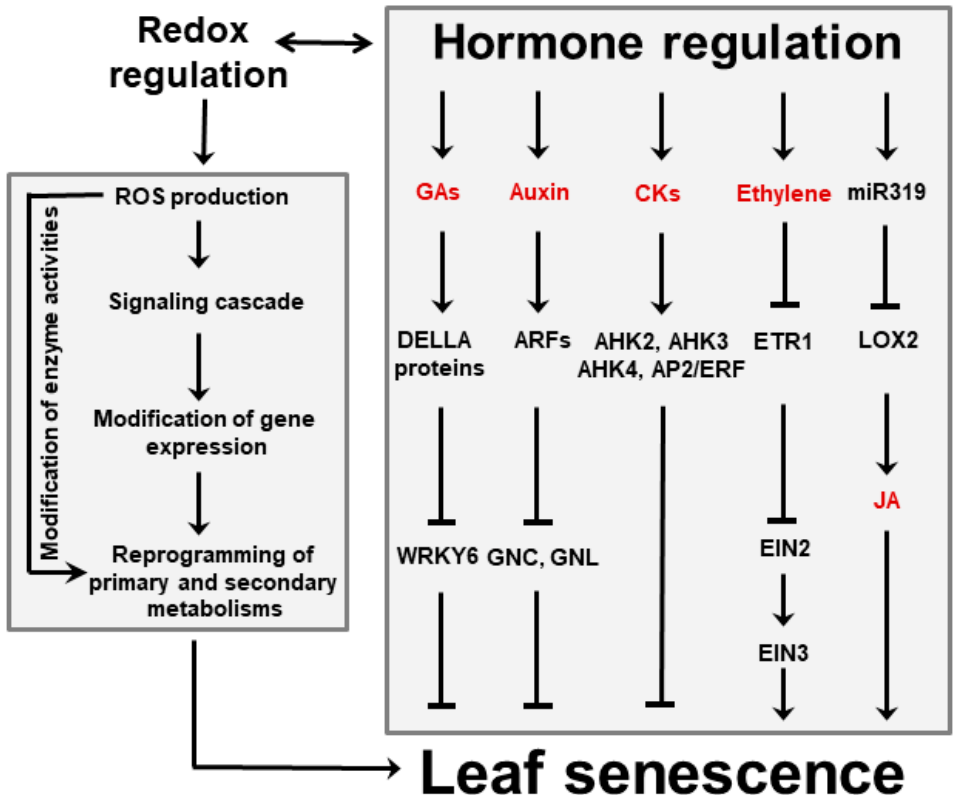
Figure 3. Interactions between hormones and ROS during leaf senescence regulation. Plant hormones can affect leaf aging either directly or via signaling cascades in which ROS are involved. Among them, GAs, auxins and CKs delay senescence, whereas ethylene and JA favor it. Regulation of JA accumulation via miR319 and lipoxygenase 2 (LOX2) is indicated. ROS might also act as independent signaling molecules that are produced upon leaf aging and stress conditions. ROS trigger modifications of gene expression that in turn result in reprogramming primary and secondary metabolisms involving sugars, energy, amino acids and antioxidants. Examples of reported interactions between hormones and ROS are given in the text. Abbreviations for hormones are also found there. AHK, Arabidopsis histidine kinase; AP2, Apetala 2; CKs, cytokinins; EIN, ethylene-insensitive protein; ERF, ethylene-responsive factor; ETR1, ethylene receptor 1; GNC, carbon-metabolism involved; GNL, GNC-like.